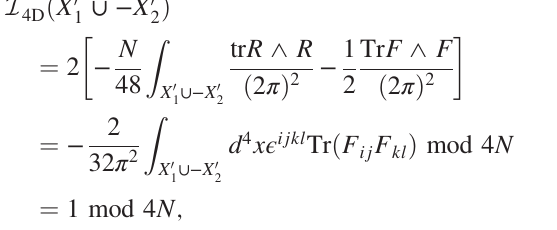
FIG. 3. X 0 1 are glued along their common boundary T 3 . There ; 2 is a unit U ð N Þ instanton labelled by “ * ” inside D inducing a flux through D X 0 1